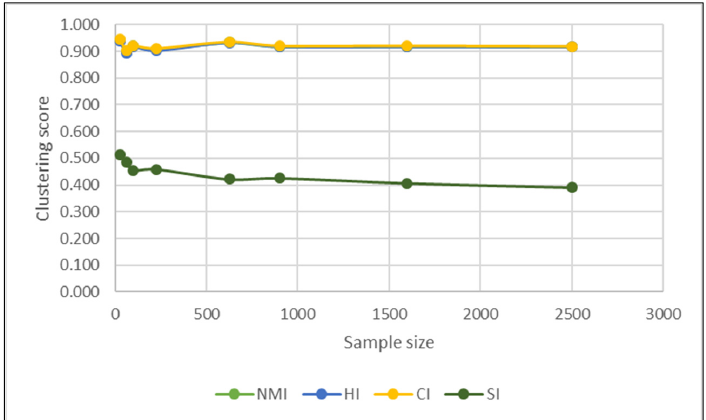
Figure 7. Optimal perplexity relation against sample count.